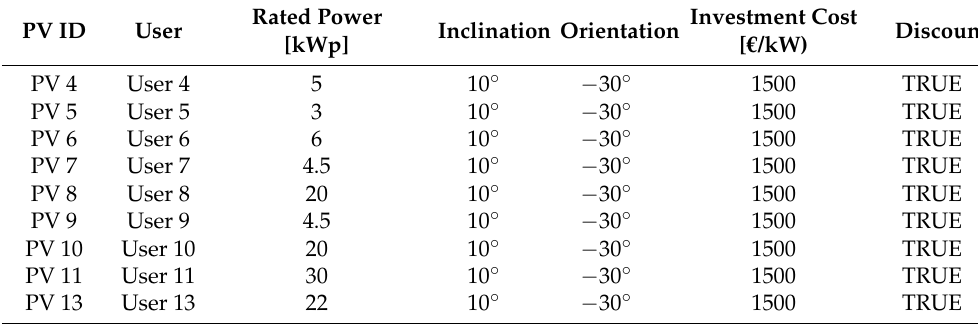
Table 5. Available generators